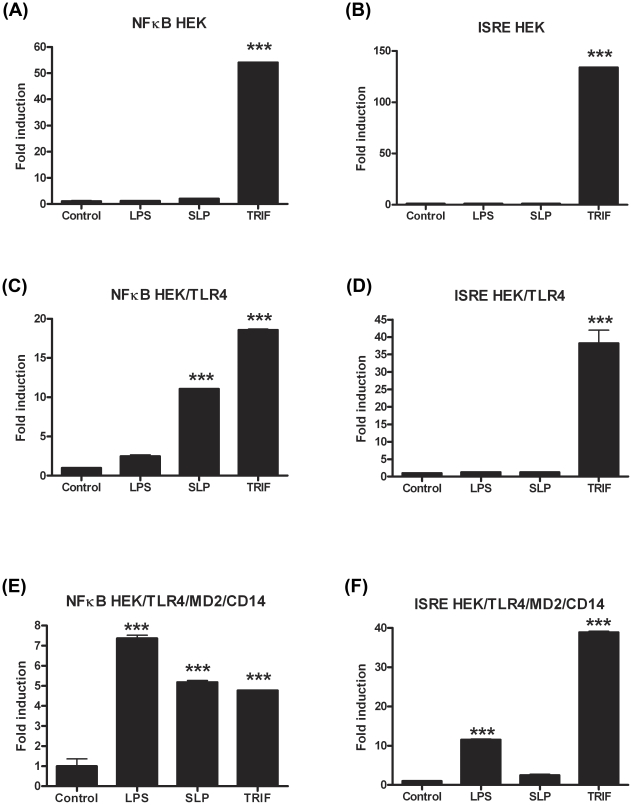
SLPs activate NFκB independently of CD14.HEK293T cells, HEK293T-TLR4 cells and HEK293-MD2-CD14-TLR4 cells were transiently transfected with ISRE-luciferase (75 ng) and Renilla-luciferase (30 ng). Twenty-four hours after transfection, the cells were stimulated with LPS (100 ng/mL) or SLP (20 µg/mL) for 6 h. The cells were lysed, and luciferase activity as an indicator of ISRE activity (B, D, F) or NFκB activity (A, C, E) was subsequently measured. Results were normalised for Renilla-luciferase activity and represented as fold stimulation over the non-stimulated control. Results are expressed as mean (± SEM) for duplicate determinations and are representative of two separate experiments. *** p<0.001, determined by one-way ANOVA test.